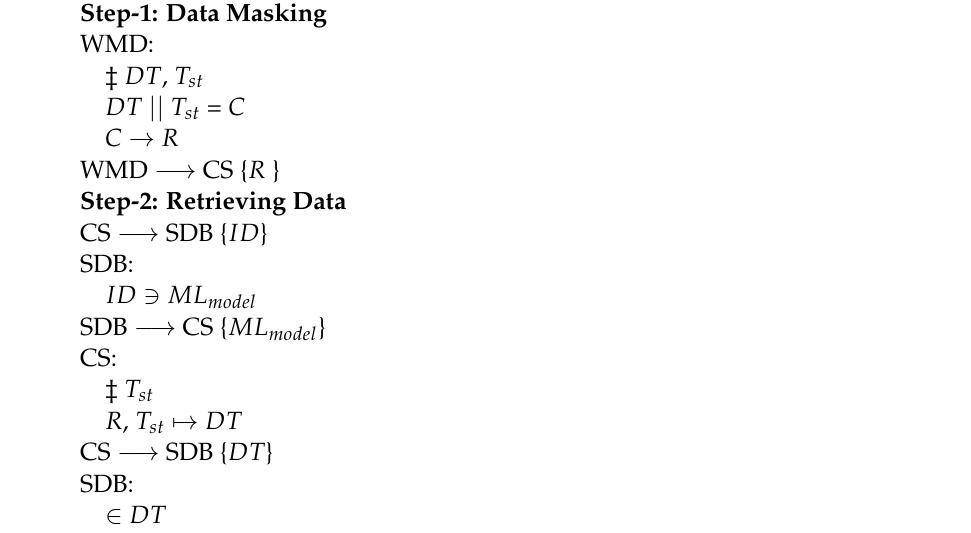
Algorithm 2: Data Masking and Retrieving